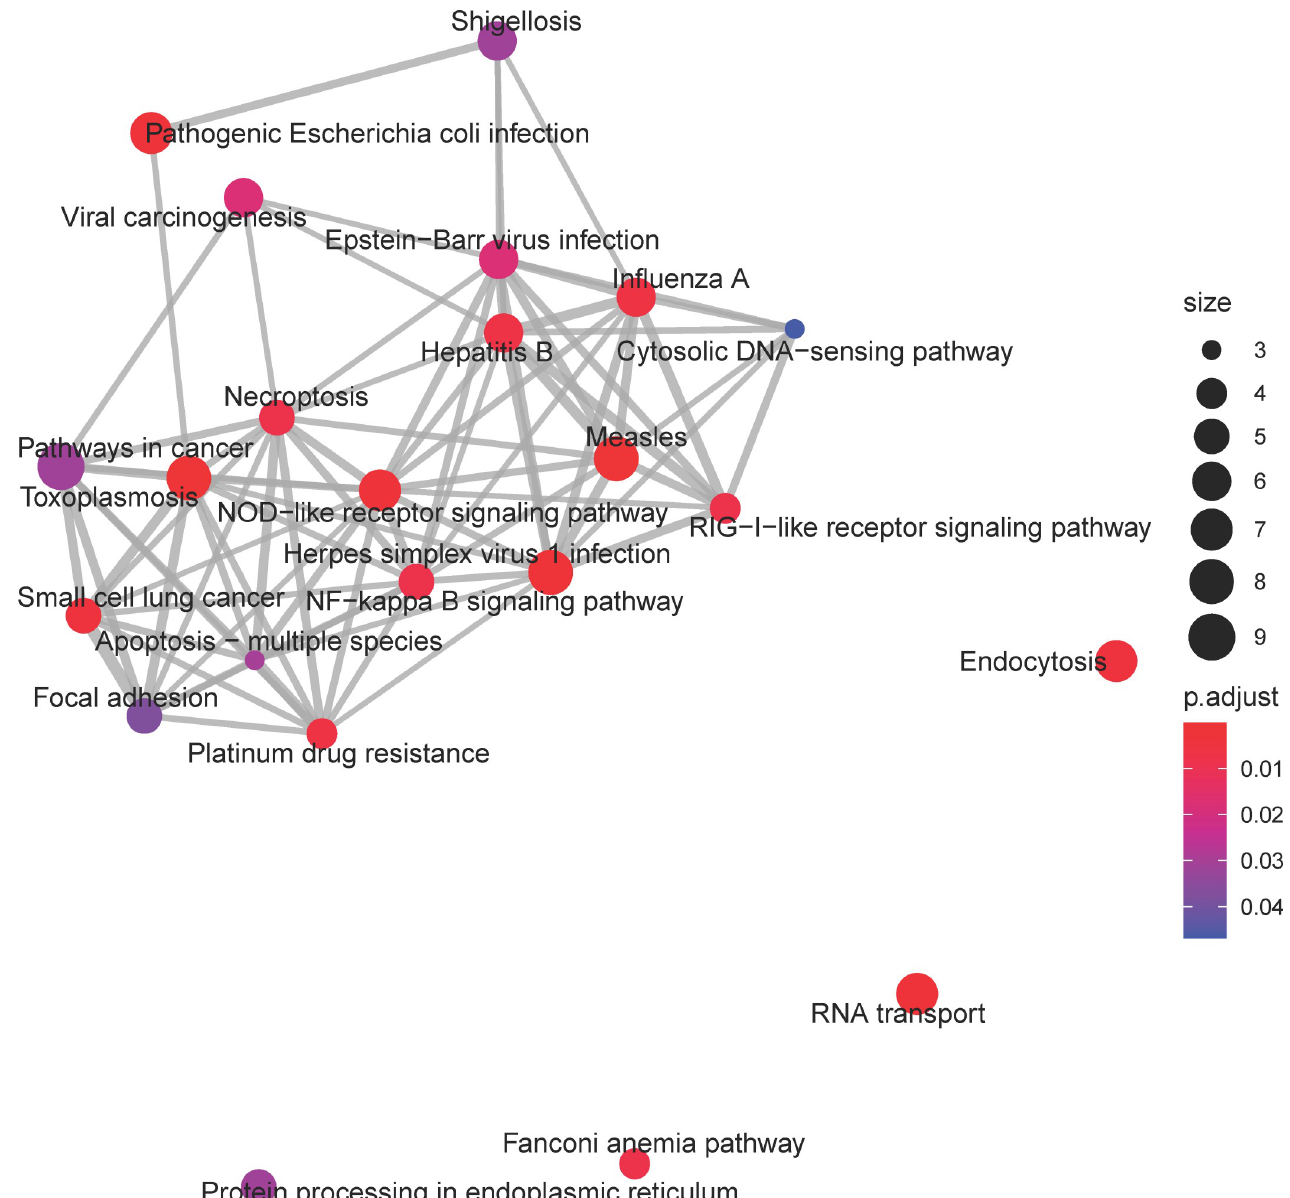
Fig 7. Enrichment map of KEGG pathways for the greenyellow consensus co-expression module. Symbol explanation as in Fig 4. Many of the significant pathways in this module have overlapping gene sets, many of which are associated with immune activation, such as NOD-like receptor signaling , RIG-I-like receptor signaling , and NF-Kappa-B signaling pathway . The increasing expression trend of this module’s eigengene throughout aging suggests consistently increased activation of these pathways in aging.